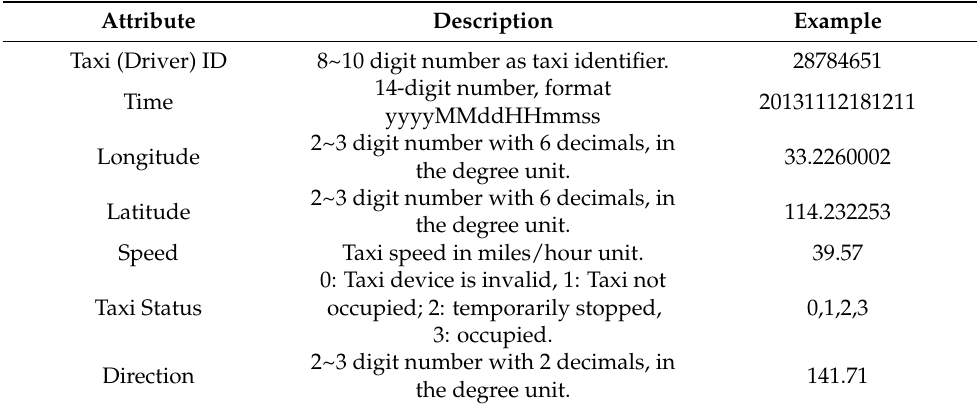
Figure 1. Framework of the proposed model. Table 1. Description of the attributes of a record in the Taxi GPS